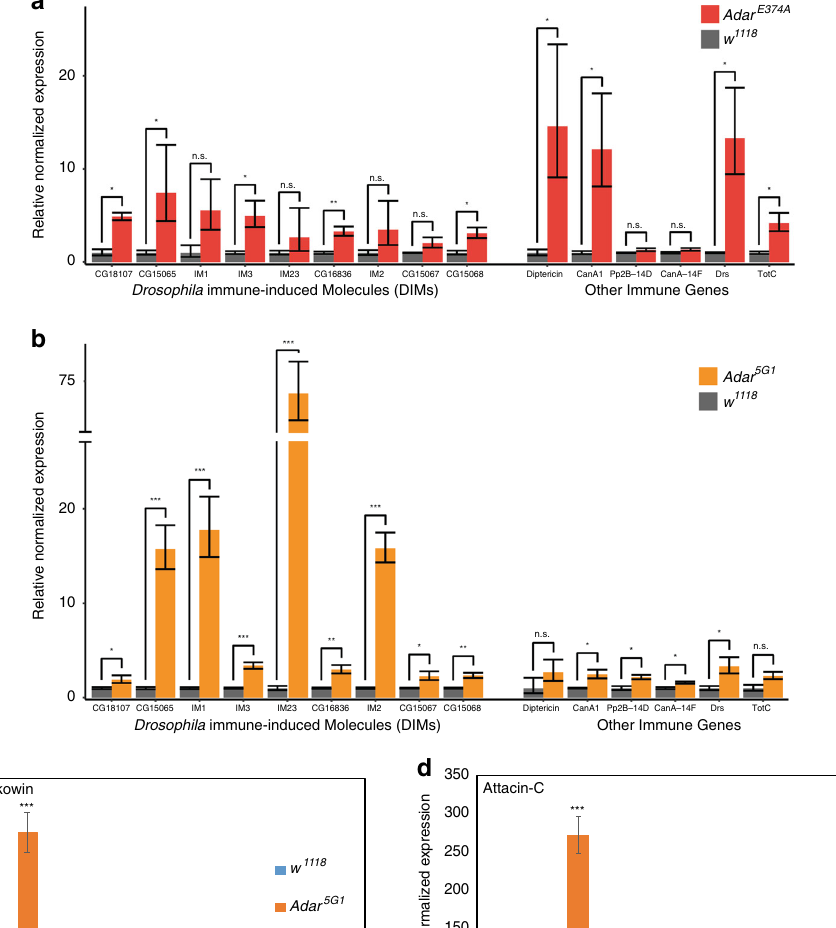
chromosomal Adar locus. Since expressing human ADAR2 in ted it seems likely that the involvement of Drosophila Adar and not mouse Adar2 in innate immune responses is probably not mainly due to differences between these homologous proteins in verte- brates and fl ies but due to the particular set of RNAs edited by Adar in Drosophila . Association of ADAR1 type proteins with innate immunity and ADAR2 type proteins with